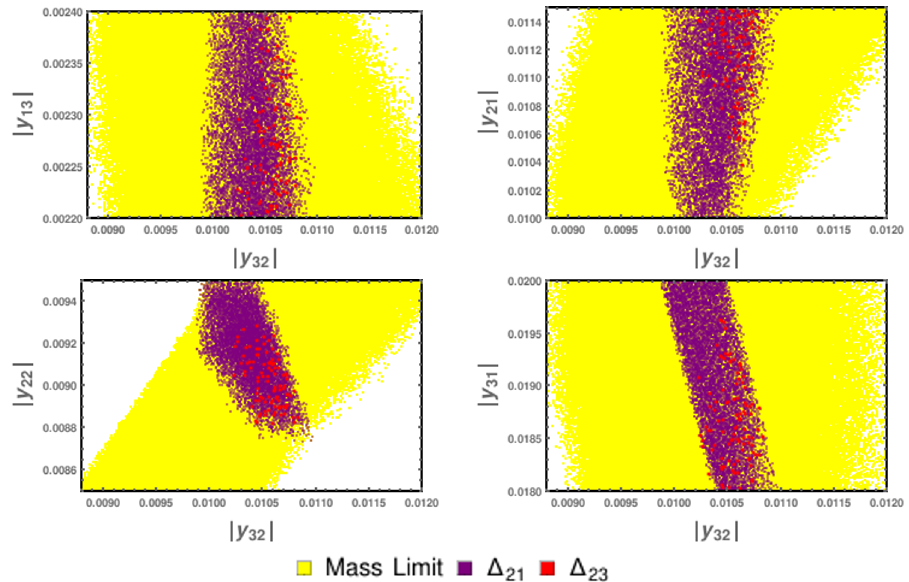
Figure 2. Correlation of Yukawa couplings in the Dirac sector for an inverted hierarchy of neu- trino